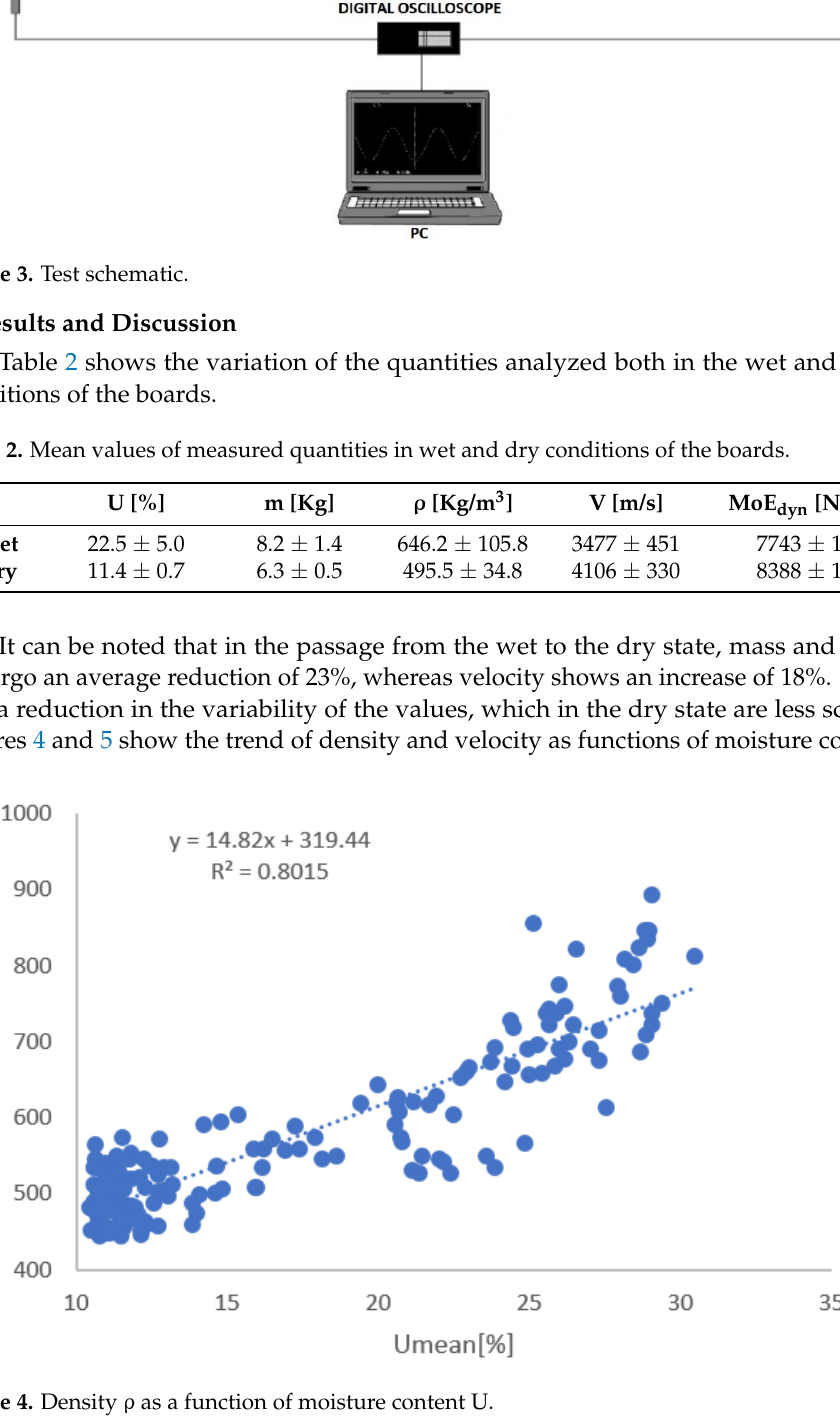
Figure 5. Velocity V as a function of moisture content U. Density and velocity have an inverse relationship with moisture content with respect to each other. As the drying progresses and the moisture level decreases, a decrease in density is observed, as expected, resulting from the decrease in the water content inside the wood. On the contrary, the decrease in moisture content corresponds to an increase in the propagation velocity of the sonic wave, in accordance with the existing literature [61– 63] on the relationship between wave velocity and moisture content, which presents dif- ferent relationships depending on of the wood species. In most species, the increase in velocity from the wet state to the saturation point is not very significant, while from the saturation point to the dry state it is much greater; this is explained as follows [52]. For low water contents (U < 18%), when water is present in the cell walls as bound water, the elastic wave is dispersed by the wood and the cell boundaries. The lateral units of OH or other radicals of the cellulosic material can reorient their position under the elastic stress. In this case, the attenuation mechanism related to the cellulosic cell wall material is prob- ably the most important. With a higher moisture content but below the saturation point, scattering at the cell boundaries may be the most important loss mechanism. When the